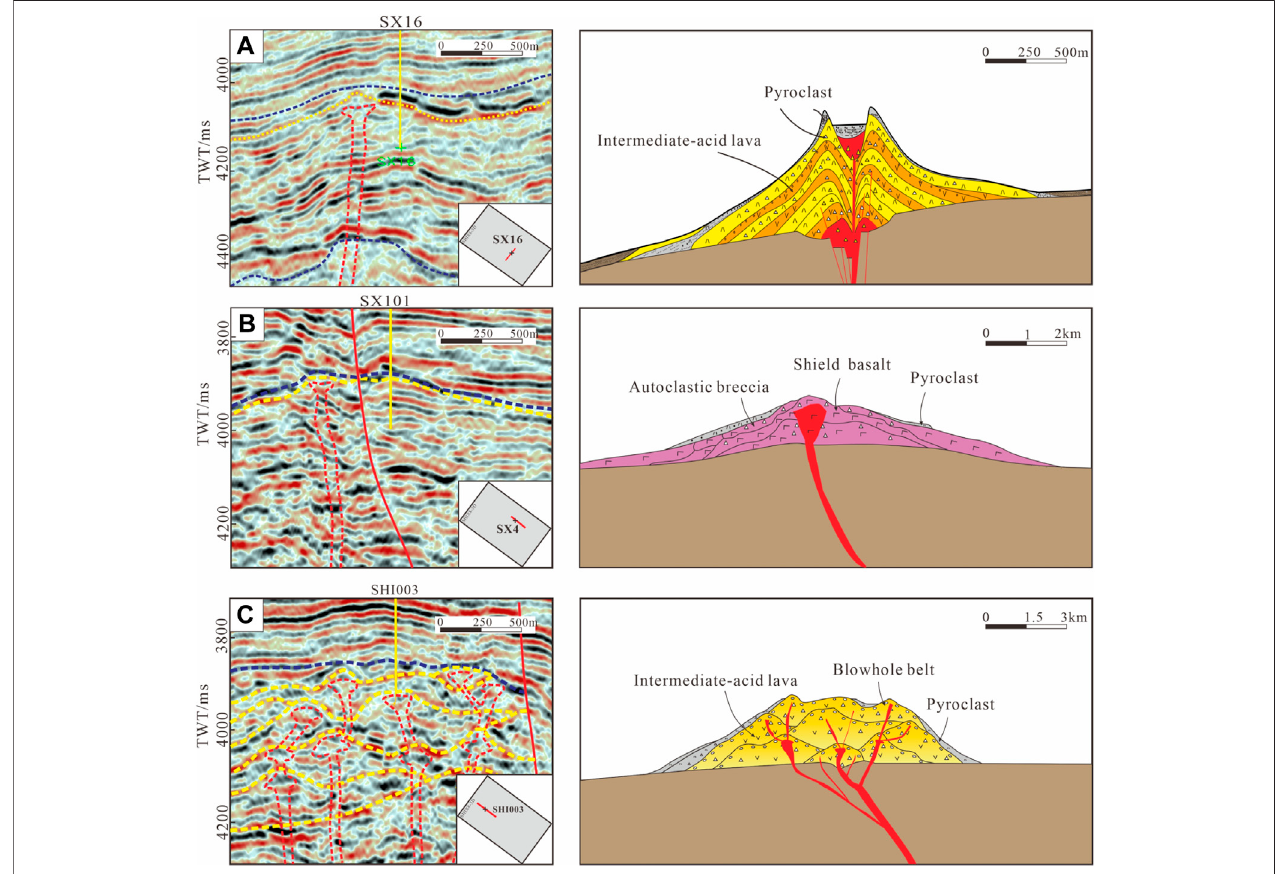
FIGURE 3 | Types and development models of Carboniferous volcanic edi fi ces in the Shixi